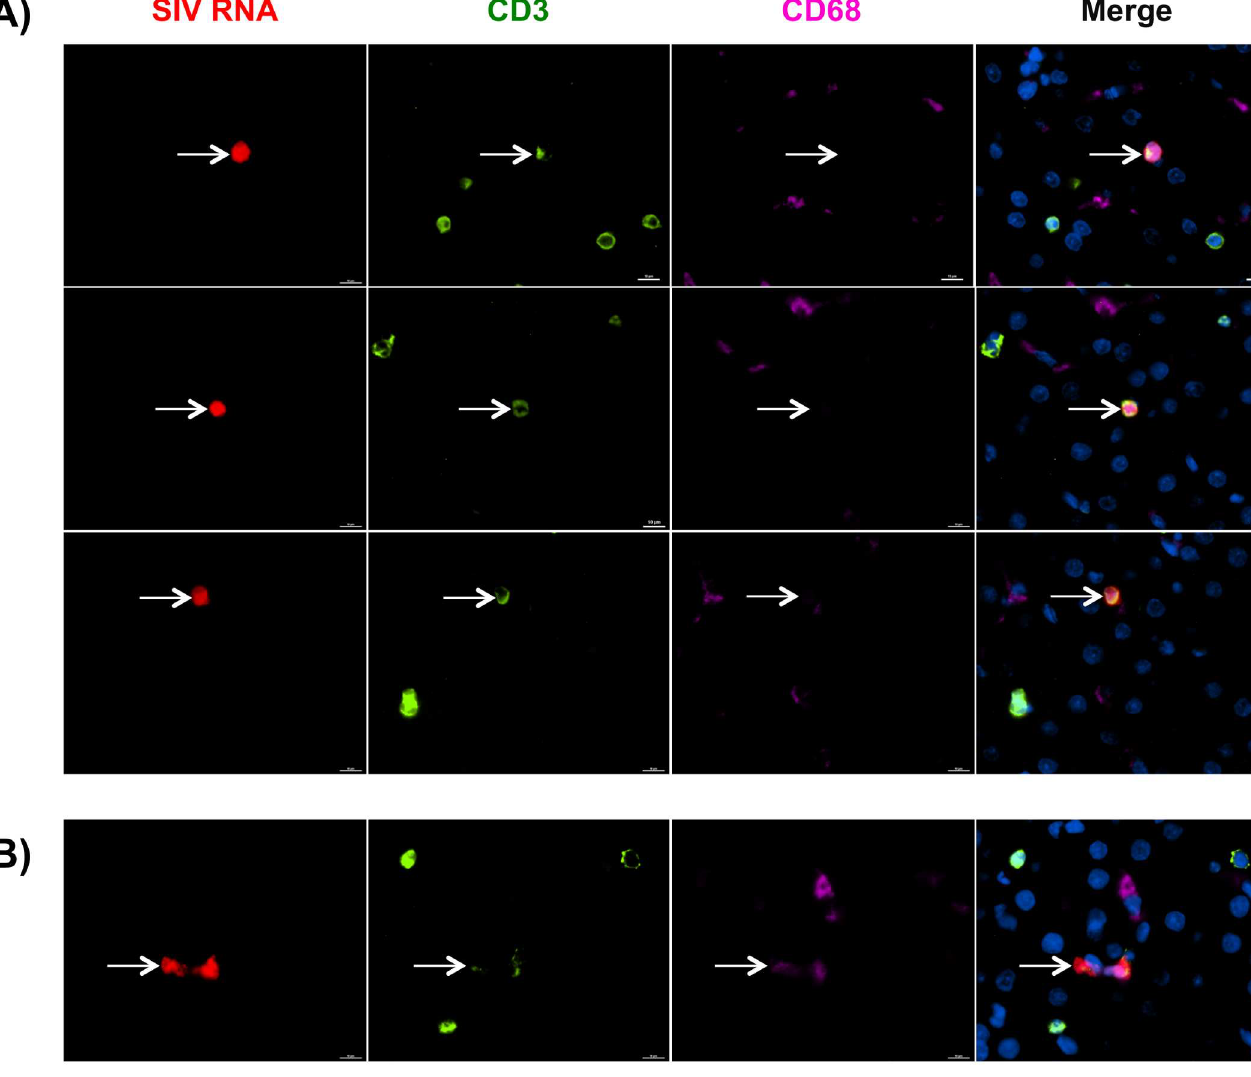
Fig 8. T cells are the primary cellular subset infected with SIV in the liver. A-B) Liver tissue sections from SIV-infected untreated macaques were assessed for SIV RNA+ cells (red) by in situ RNAscope technology followed by antibody staining with CD3 to identify T cells (green) and CD68 to identify macrophages (pink). Nuclei were stained with Dapi (blue). SIV RNA+ signal was predominately found associated with CD3 T cells (A) and in rare cases CD68 macrophages